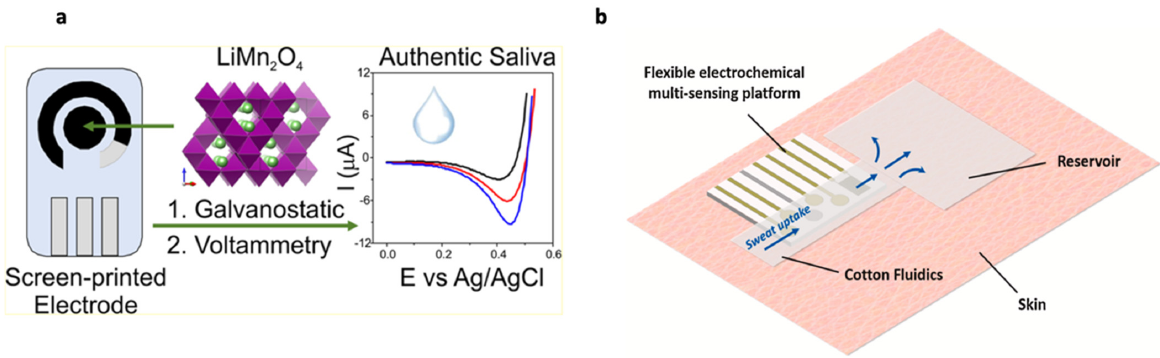
Figure 4. ( a ) LiMn2O4-modified electrodes used for the quantification of lithium ions in saliva (modified with permission from Suherman et al., ACS Sensors , 2019 [24]). ( b ) Flexible electrochemical multi-sensing platform used for quantification of lithium concentrations in sweat (modified with permission from Criscuolo et al., Sensors and Actuators , 2021